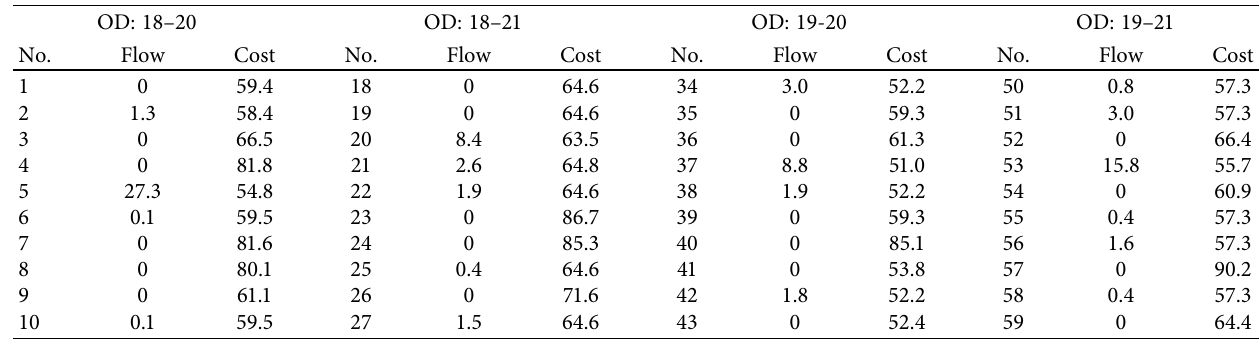
Table 5: Results of the hybrid